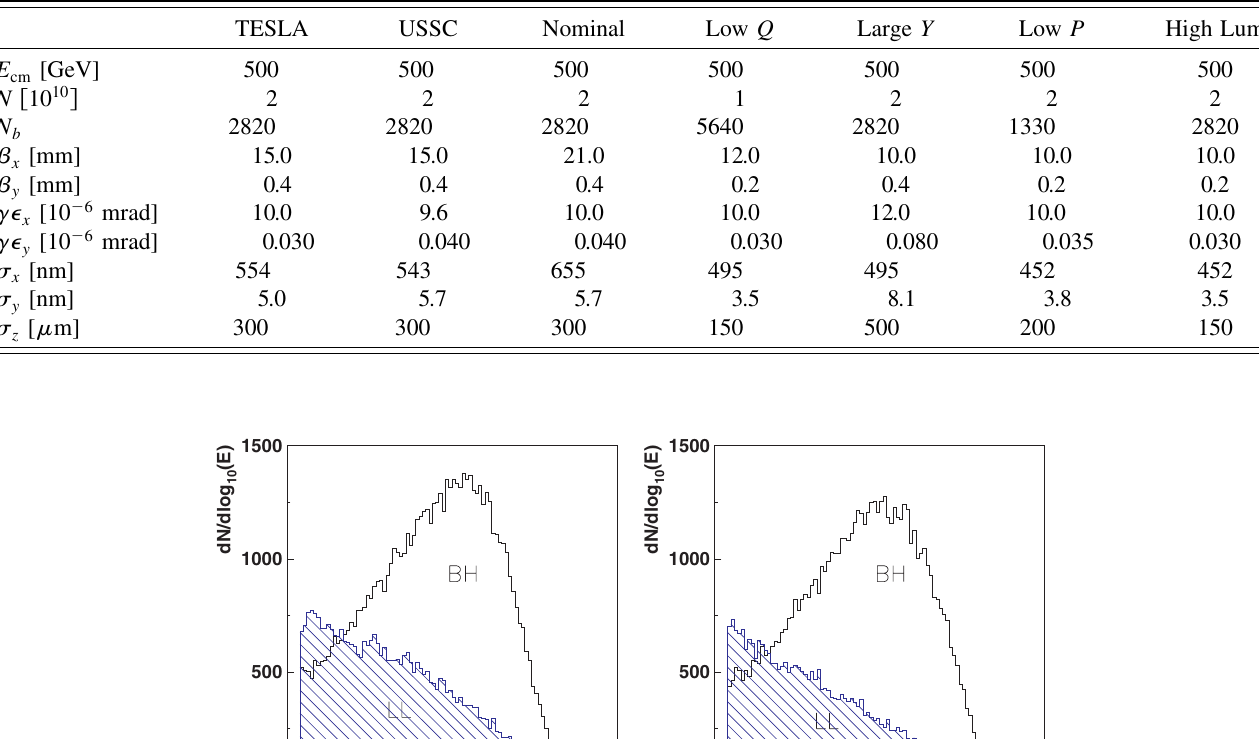
TABLE I. Beam parameters for different ILC design optimizations under consideration. E is the center of mass energy of the cm the number of bunches per train, (cid:2) are the beta functions at the interaction point, (cid:3)(cid:4) collision, N the number of particles per bunch, N b are the normalized emittances, and (cid:5) are the bunch dimensions at the interaction point.